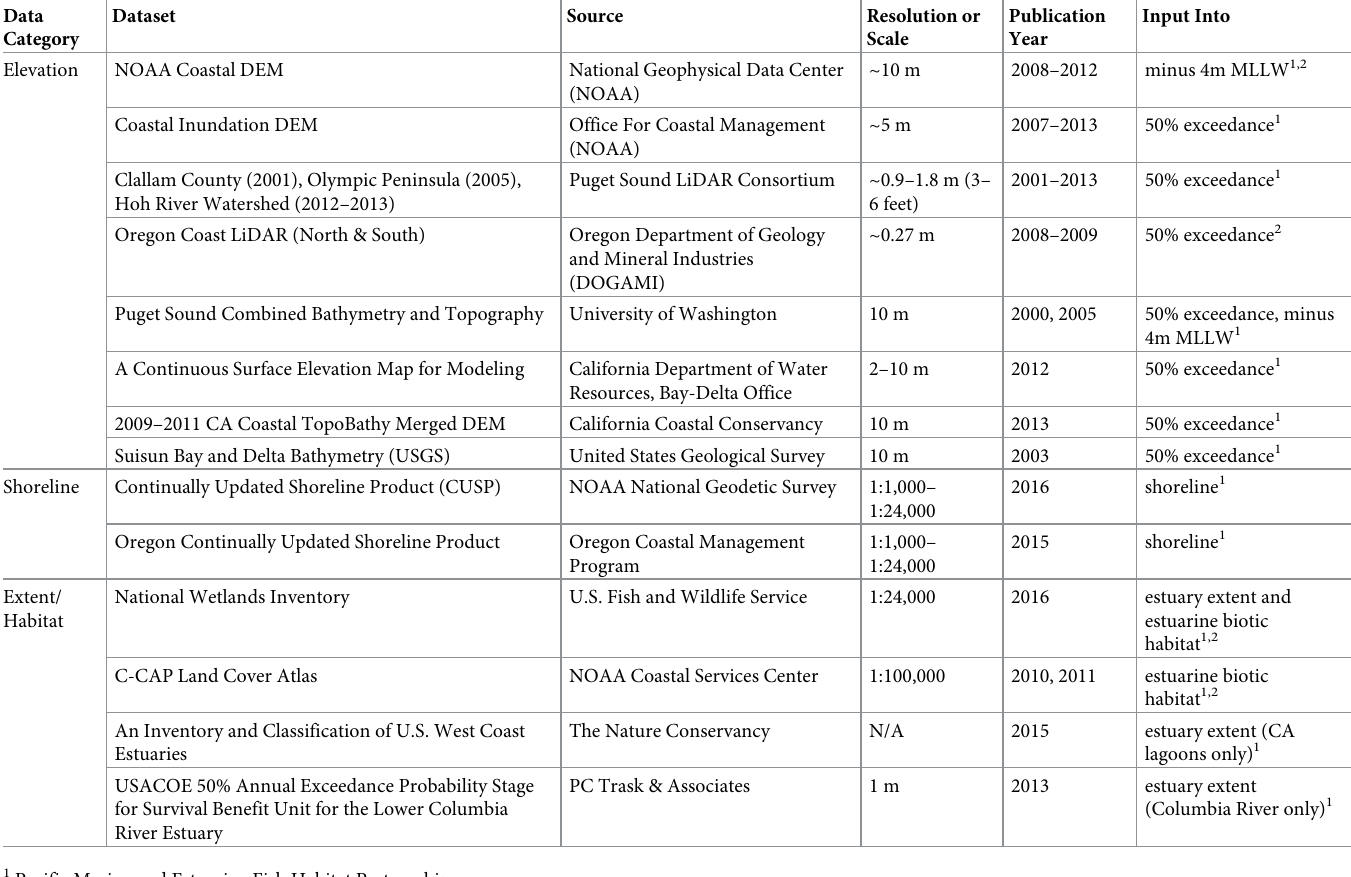
Table 1. Data sources for estimation of elevation-based estuary extent model (EBEEM) and wetland loss, and how data were used in GIS modeling. See S1 File for URLs to elevation data